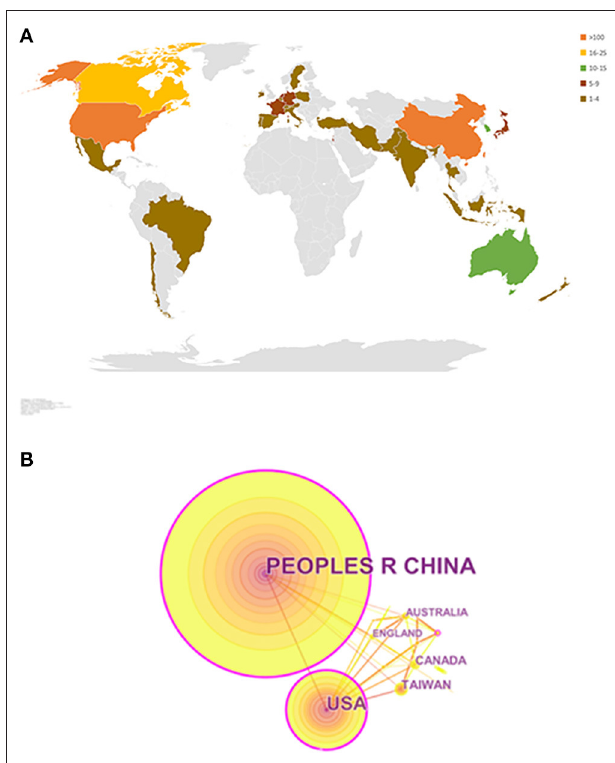
FIGURE 2 | (A) World map of publications distributed in various countries/regions from 2001 to 2020. (B) Cooperation map of countries/regions from 2001 to